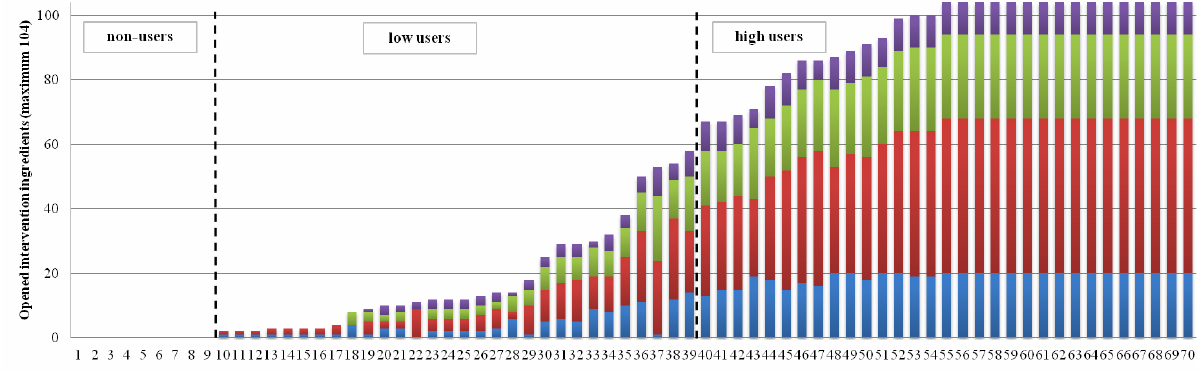
Figure 2. Distribution of total opened intervention ingredients per participants